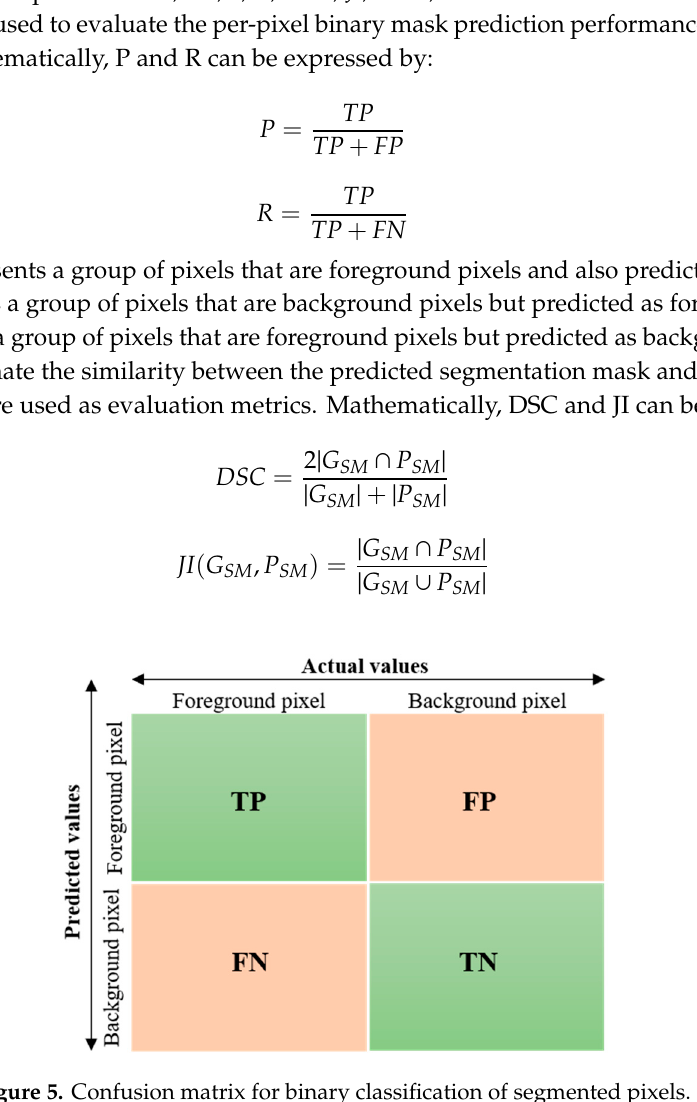
Figure 5. Confusion matrix for binary classification of segmented pixels.